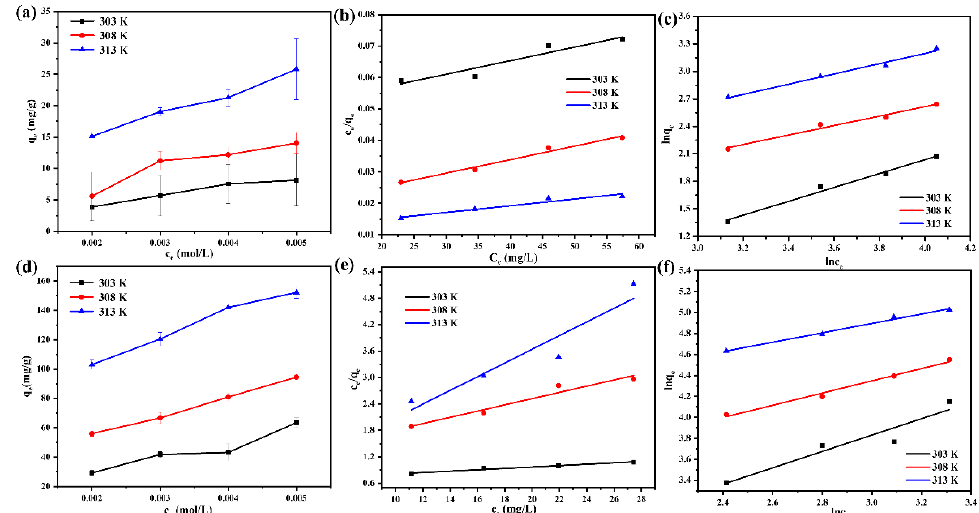
Figure 8. ( a ) The effect of initial concentration on the adsorption capacity; the fitting results of the experimental adsorption isotherm data in terms of Langmuir ( b ) and Freundlich ( c ) models of In(III) adsorbed on EGCG. ( d ) The effect of initial concentration on the adsorption capacity; the fitting results of the experimental adsorption isotherm data in terms of Langmuir ( e ) and Freundlich ( f ) models of Fe(III) adsorbed on EGCG.